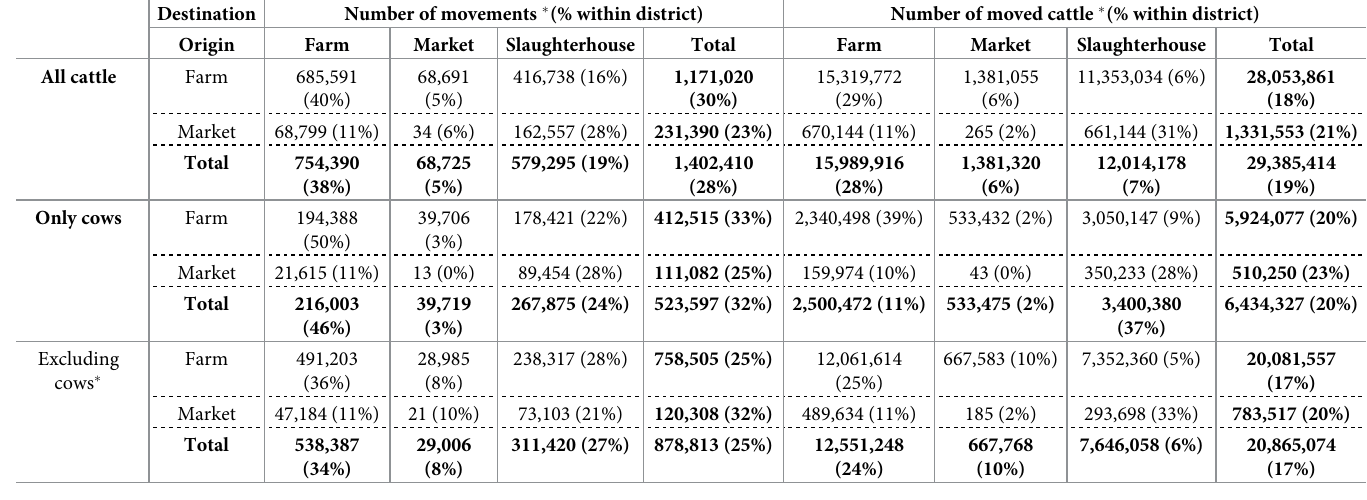
Table 3. Summary of cattle movements within and between districts in Paraguay from 2014 to 2018. � The percentages represent the proportion of movements that occurred within districts. Destination Number of movements � (% within district) Number of moved cattle � (% within district) Origin Farm Market Slaughterhouse Total Farm Market Slaughterhouse